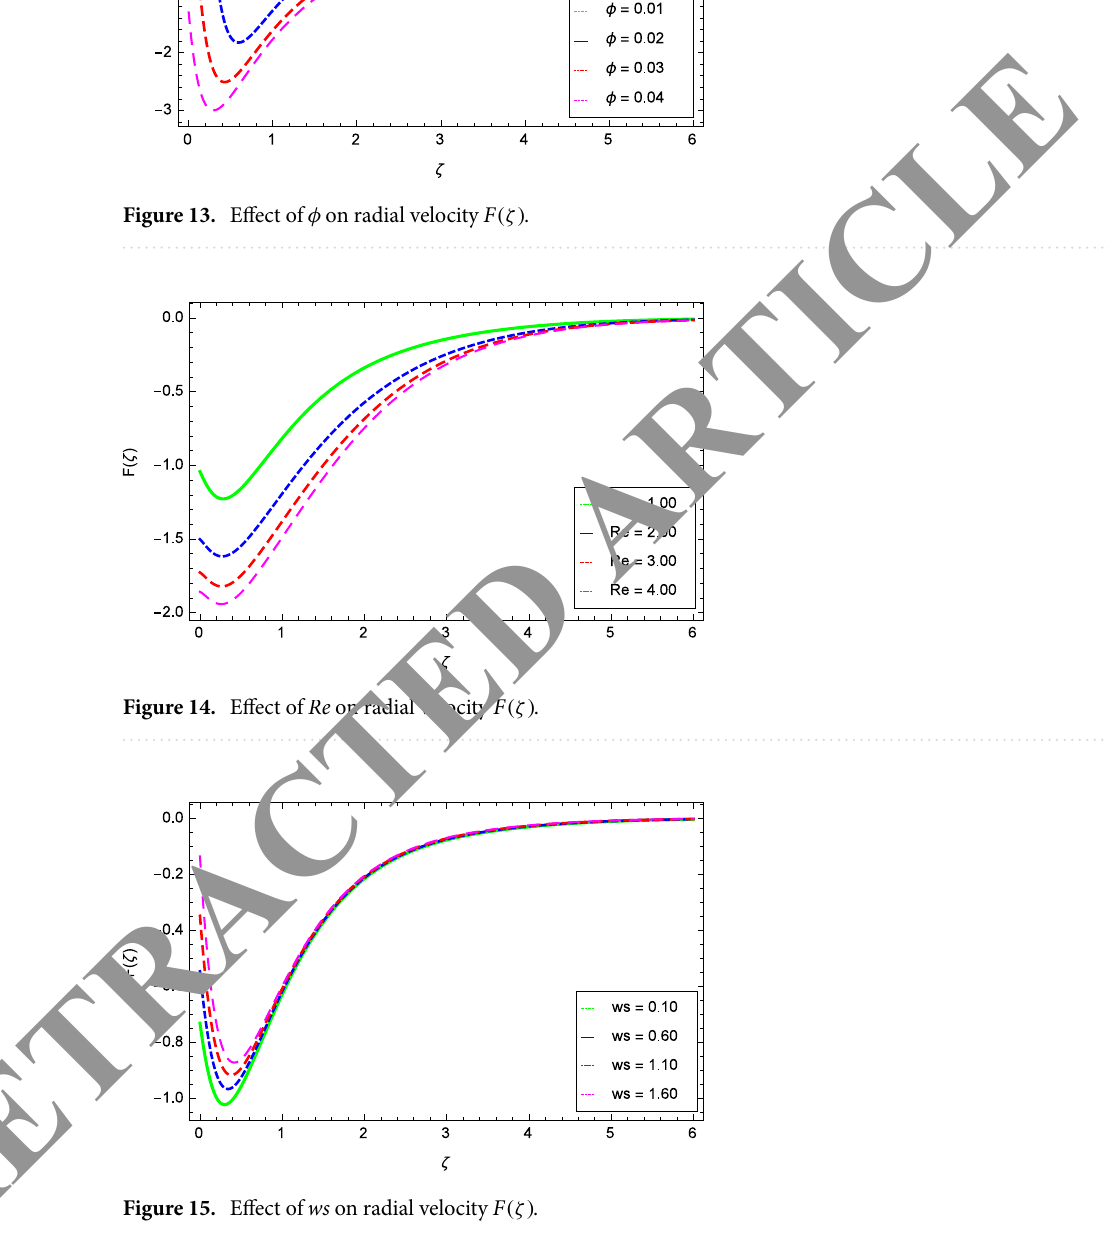
Figure 15. Effect of ws on radial velocity F (ζ) .